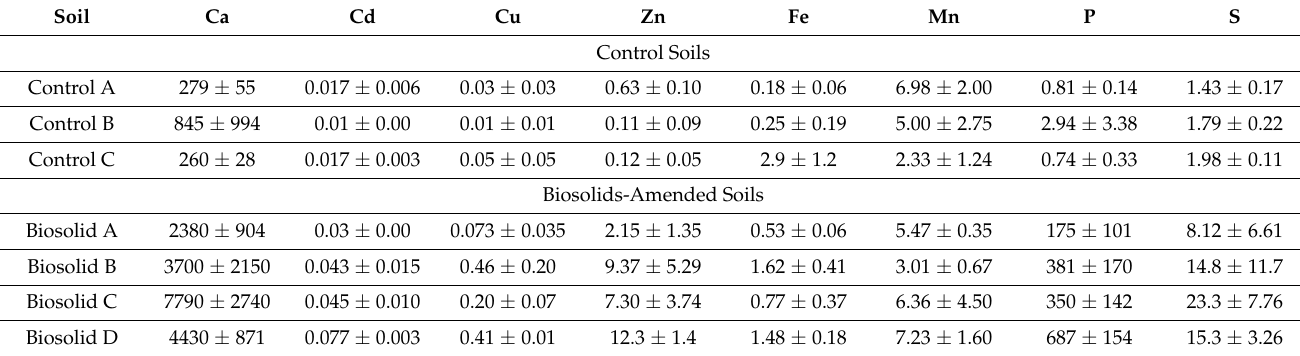
Table 4. Quantities of selected elements extracted (mg kg − 1 ) from biosolids-amended and unamended (control) soils by the Modified Morgan